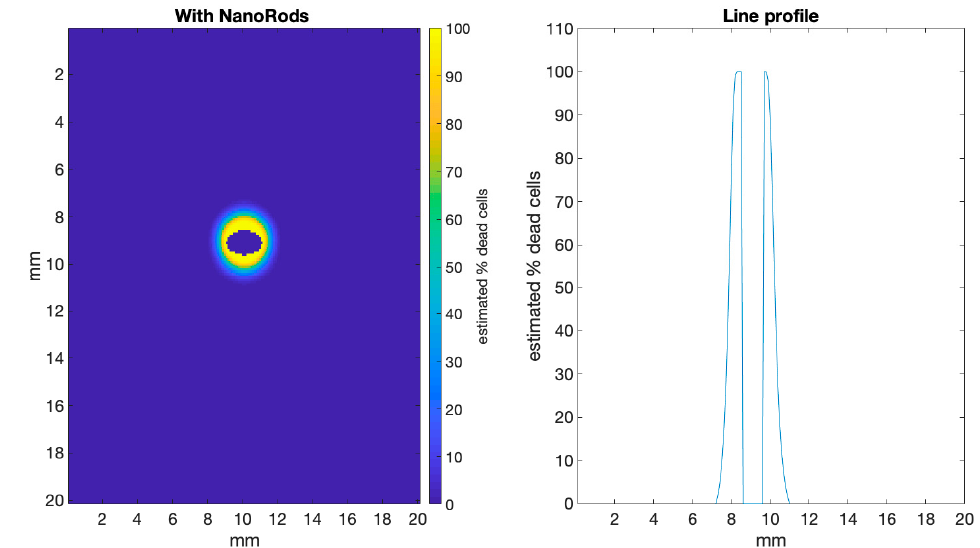
Figure 6. Shows the same data as in Figure 5 (bottom panel) but with the tumour region masked, so that the damage to normal tissue can be more easily visualized. The line profile, with the tumour data removed, clearly shows that normal tissue ~1 mm around the tumour receives a dose where close to 100% of the cells are estimated to die.